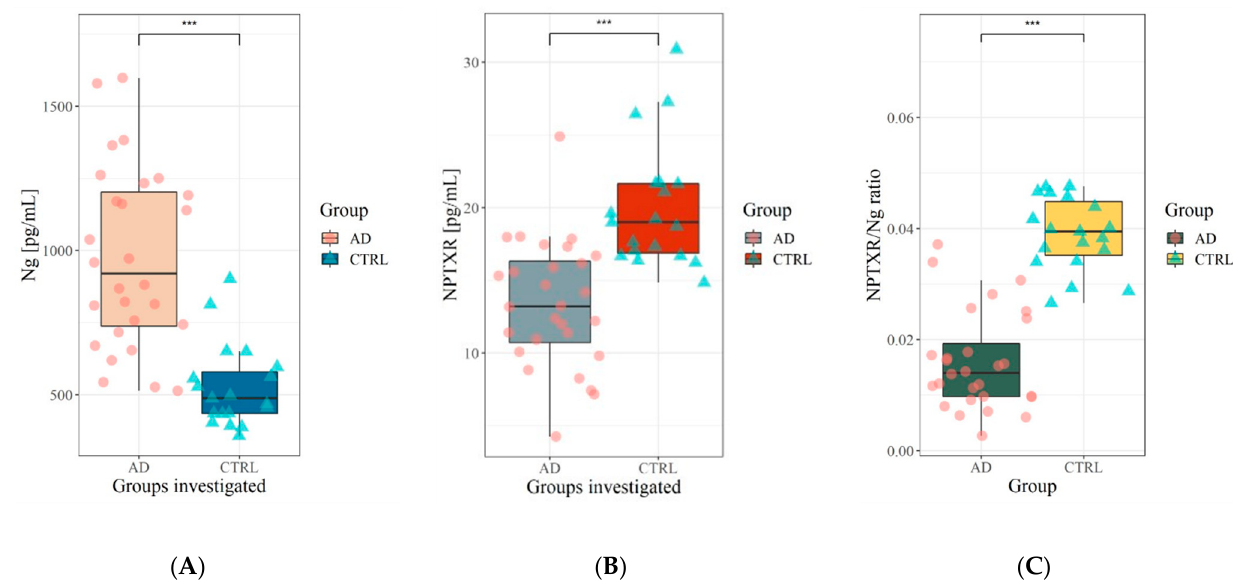
Figure 1. ( A ) Cerebrospinal fluid level of neurogranin in AD and CTRL group; ( B ) Cerebrospinal fluid concentration of neuronal pentraxin receptor in AD and CTRL group; ( C ) NPTXR/Ng ratio in AD and CTRL group. Legend—Level of statistically significant *** p < 0.001, Ng—neurogranin, NPTXR—neuronal pentraxin receptor, NPTXR/Ng ratio—neuronal pentraxin receptor to neurogranin ratio, AD—Alzheimer’s disease, CTRL—control, CSF—Cerebrospinal fluid.